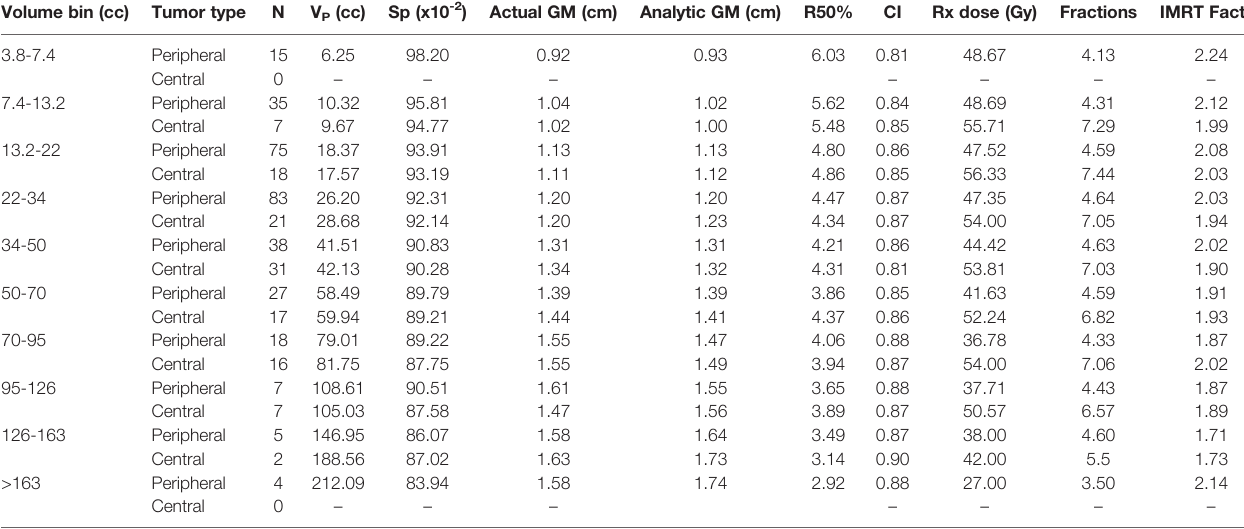
TABLE 1 | Averages of the data for all lung SBRT treatment